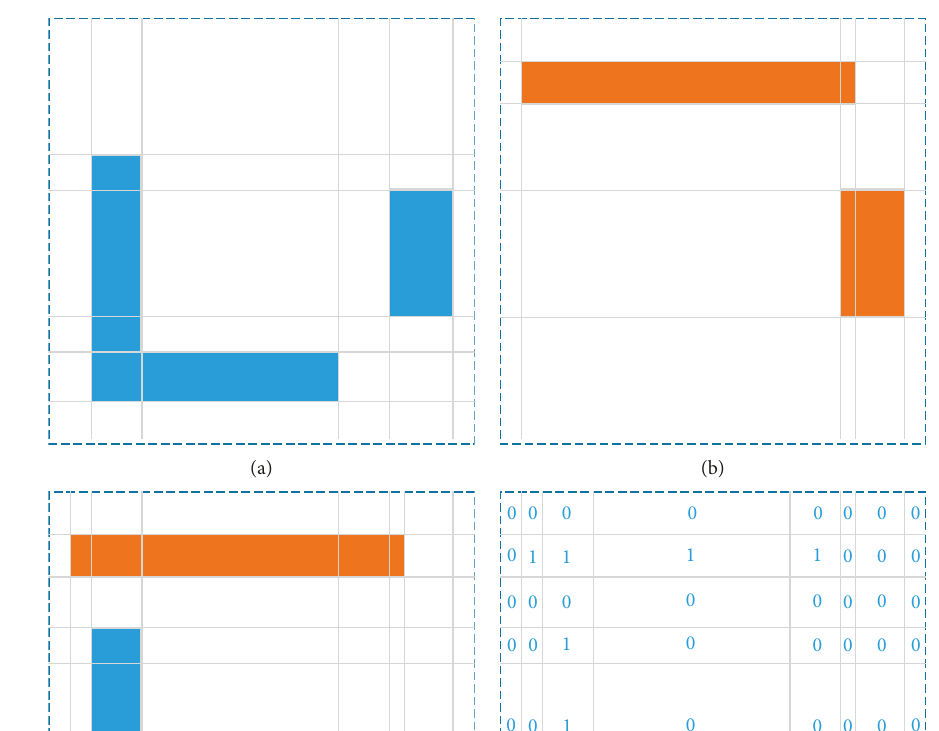
Figure 8: Reorientation of the clip.